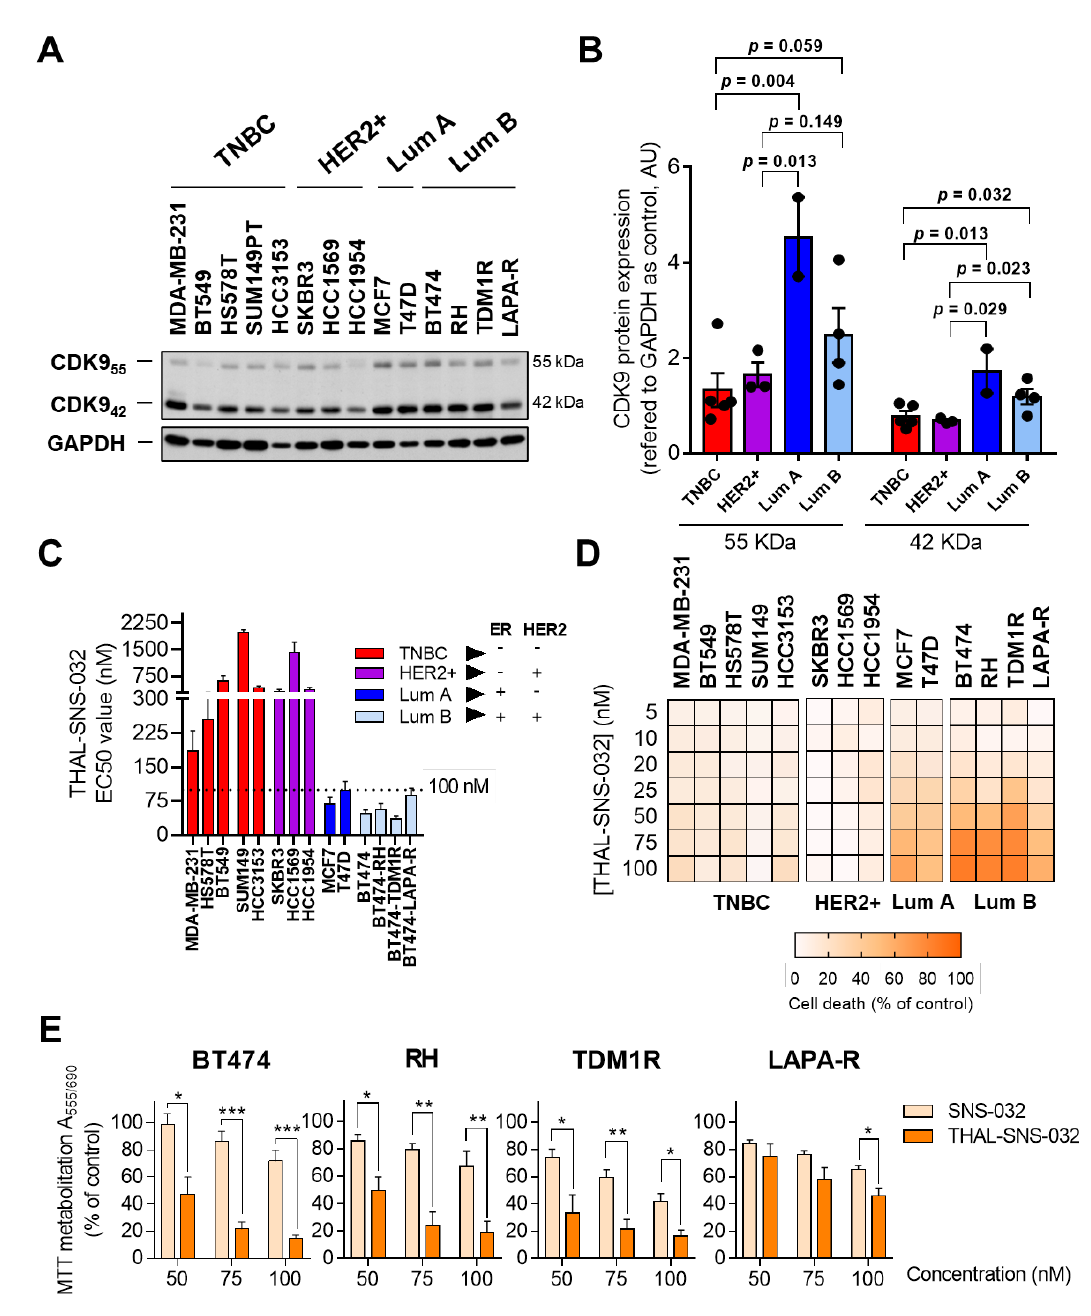
Figure 2. Evaluation of CDK9 protein expression and antiproliferative activity of SNS-032 and THAL- SNS-032 in breast cancer cell lines. Protein levels of CDK9 in all cell lines were analyzed by Western blot ( A ). Band quantification of CDK9 protein level referred to GAPDH as the loading control ( B ). THAL-SNS-032 EC50 obtained by MTT proliferation assays in breast cancer cell lines after 72 h of treatment ( C ). Heat map depicting the effect of different doses of THAL-SNS-032 in cell death in a breast cancer cell line panel ( D ). THAL-SNS-032 reduced cell viability more than SNS-032 in BT474, BT474-RH, BT474-TDM1R, and BT474-LAPA-R at the doses indicated (72 h). We used MTT assay ( E ). * p < 0.05; ** p < 0.01; *** p <